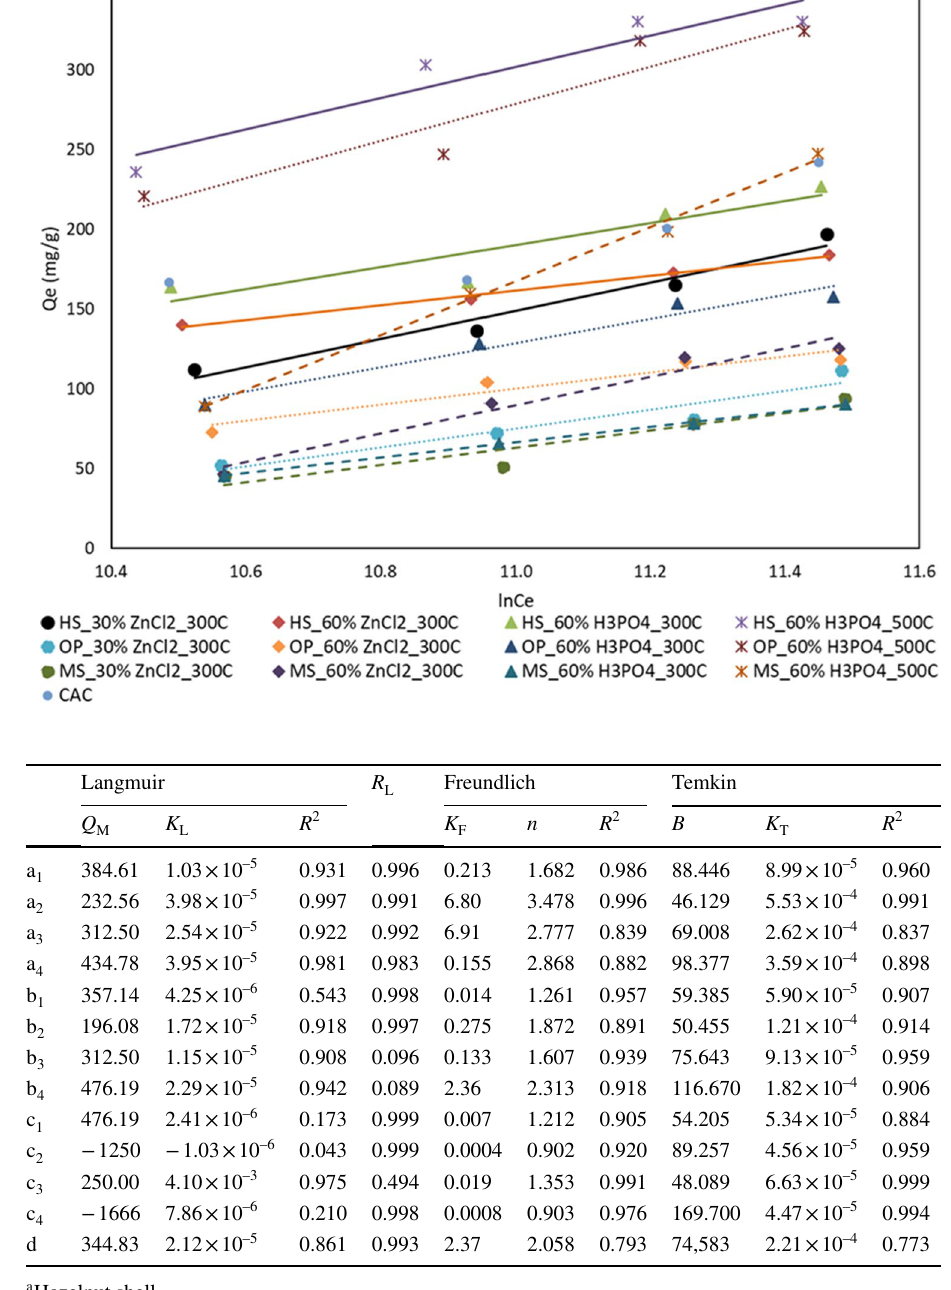
Fig. 5 Temkin isotherms of ace- tic acid adsorptions onto three activated carbons after four dif- ferent activation processes